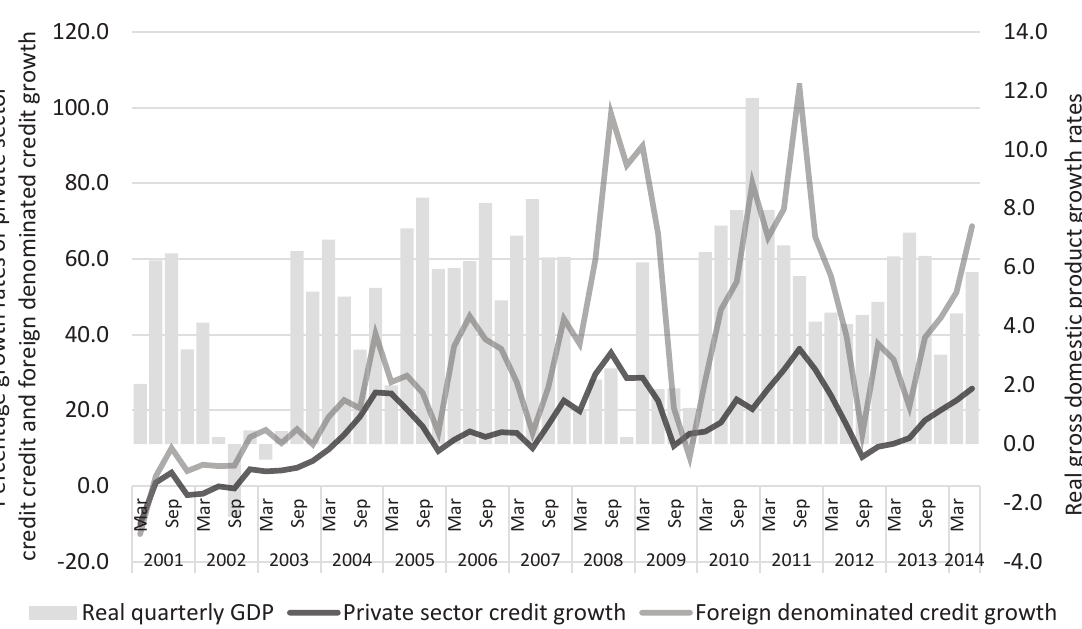
Figure 1. Growth rates of private sector credit (PSC), foreign denominated credit (FC) and real Gross